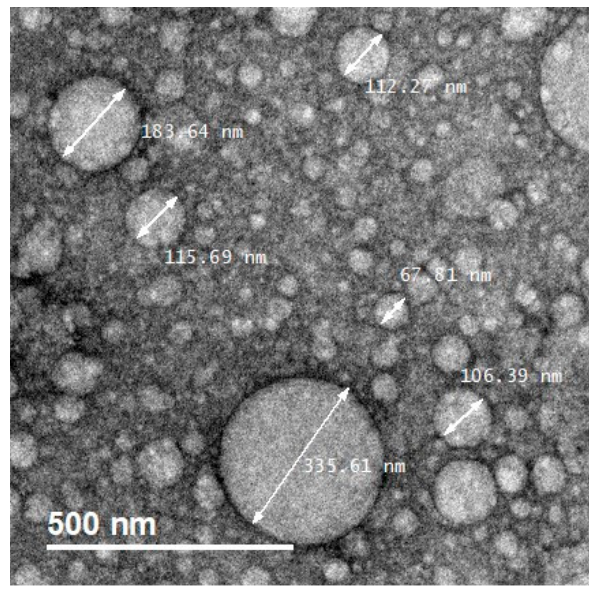
Figure 8. TEM micrographs of NAX based on AX from DDGS.